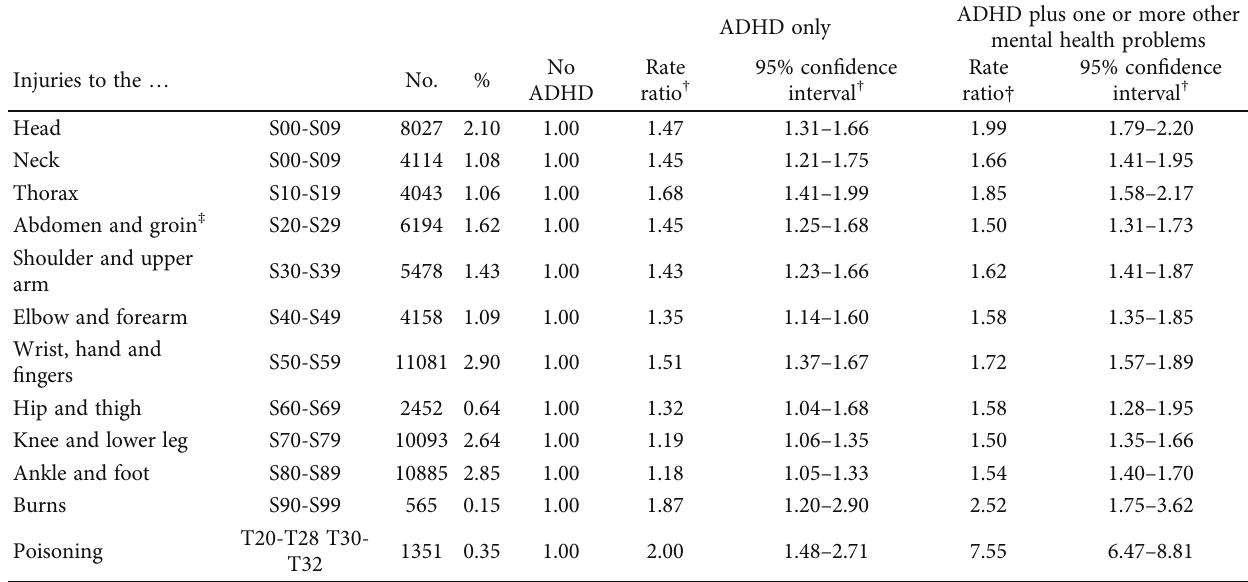
Table 3: Rate of selected types of injury for ADHD cases compared with non-ADHD cases.